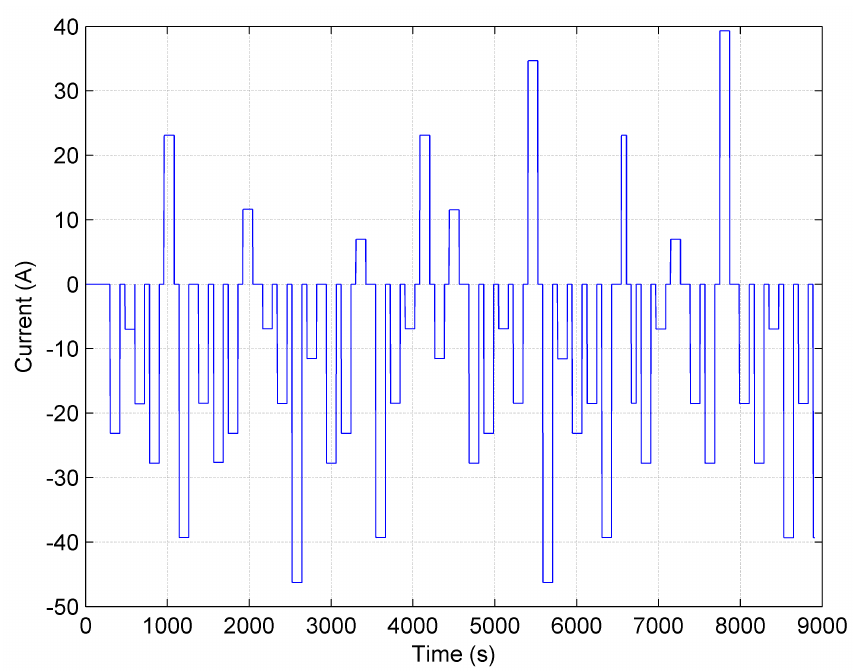
Figure 8. The current profile of dynamic experimental